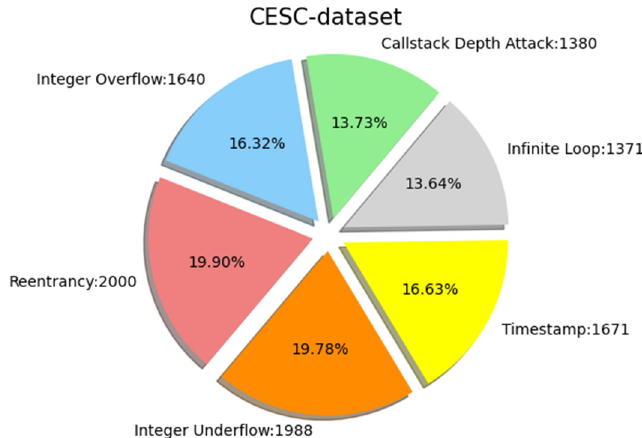
Figure 8. Composition of the CESC dataset.